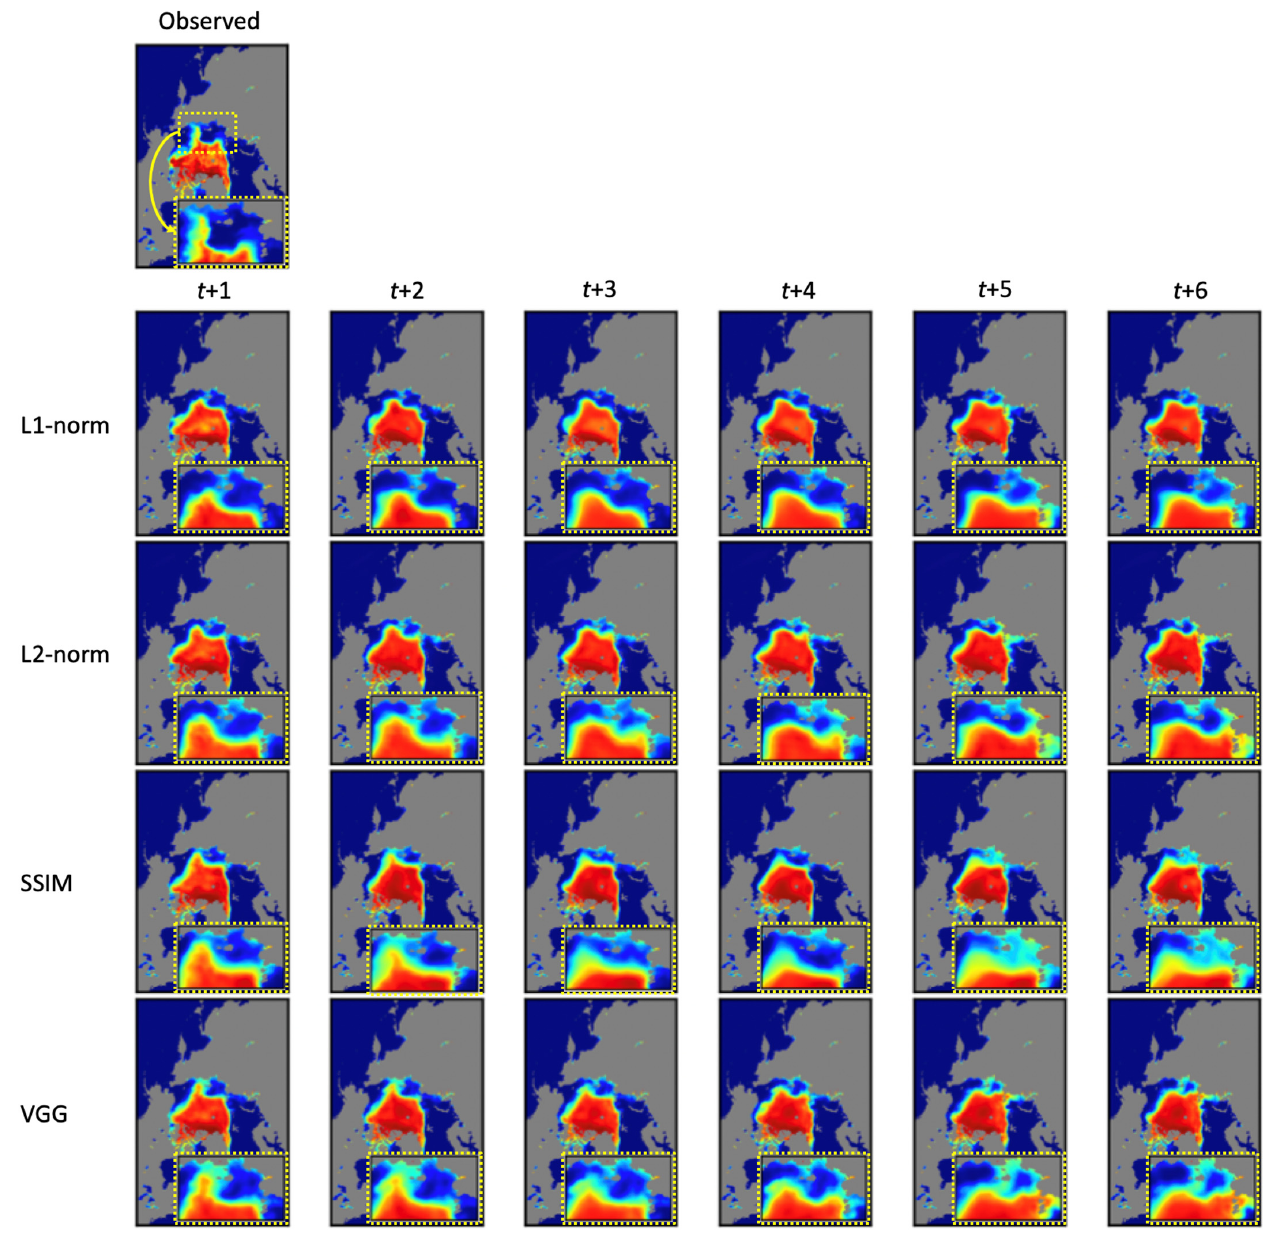
Figure 5. Visual comparisons of the predicted images based on the loss functions. One possible explanation is that the proposed VGG loss is close to human vision.